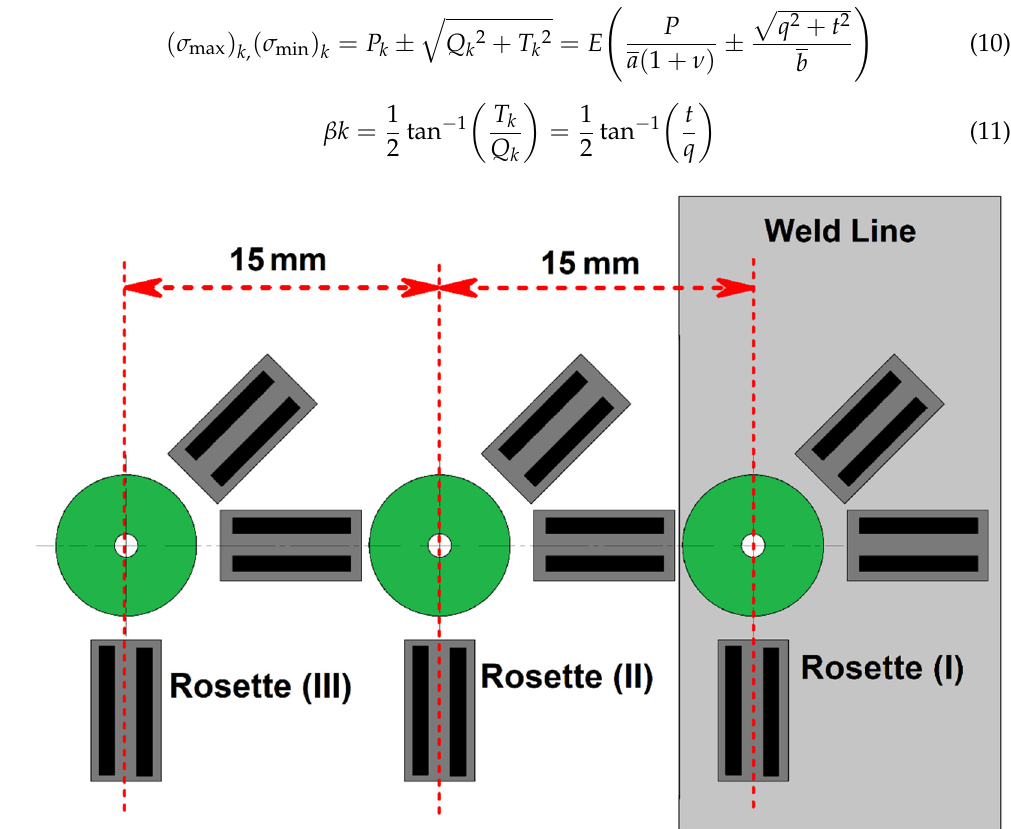
Figure 2. Schematic view of rosette placement on joint line.